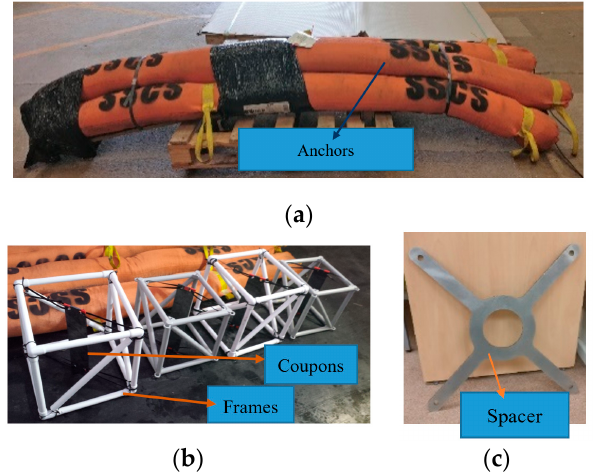
Figure 2. ( a ) Anchors that are attached to the frames, ( b ) Coupons mounted inside frames using high strength marine cable ties, ( c ) Line spacer that prevents twisting of the ropes.